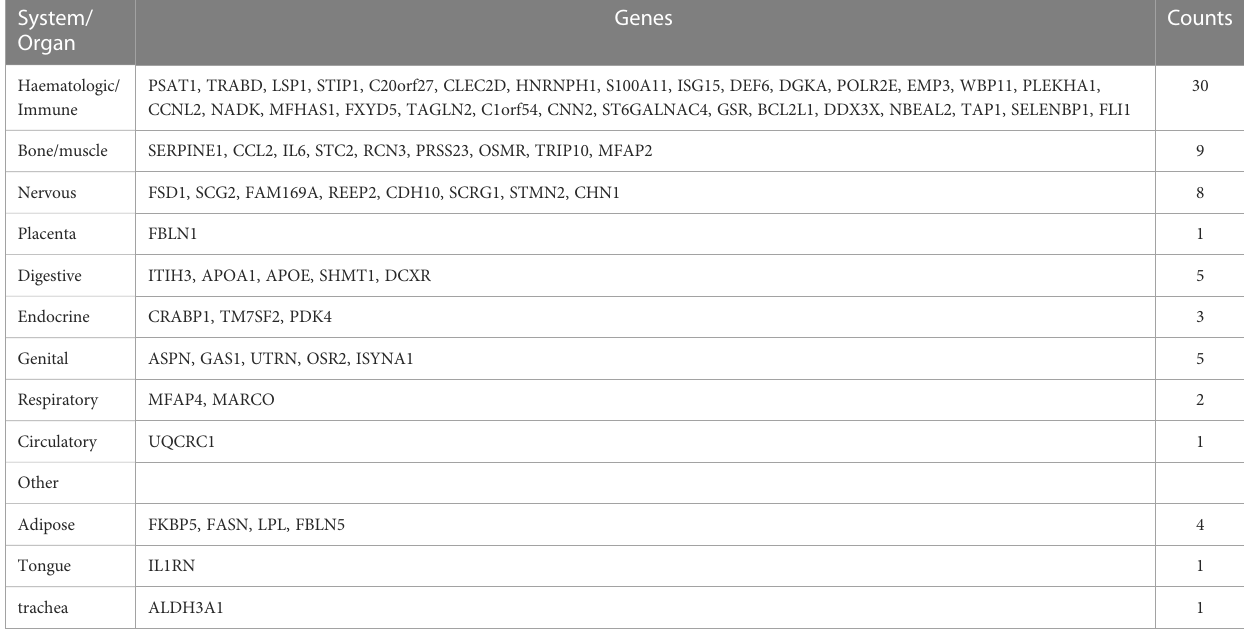
TABLE 2 Distribution of tissue/organ-speci fi cally expressed genes identi fi ed by BioGPS.